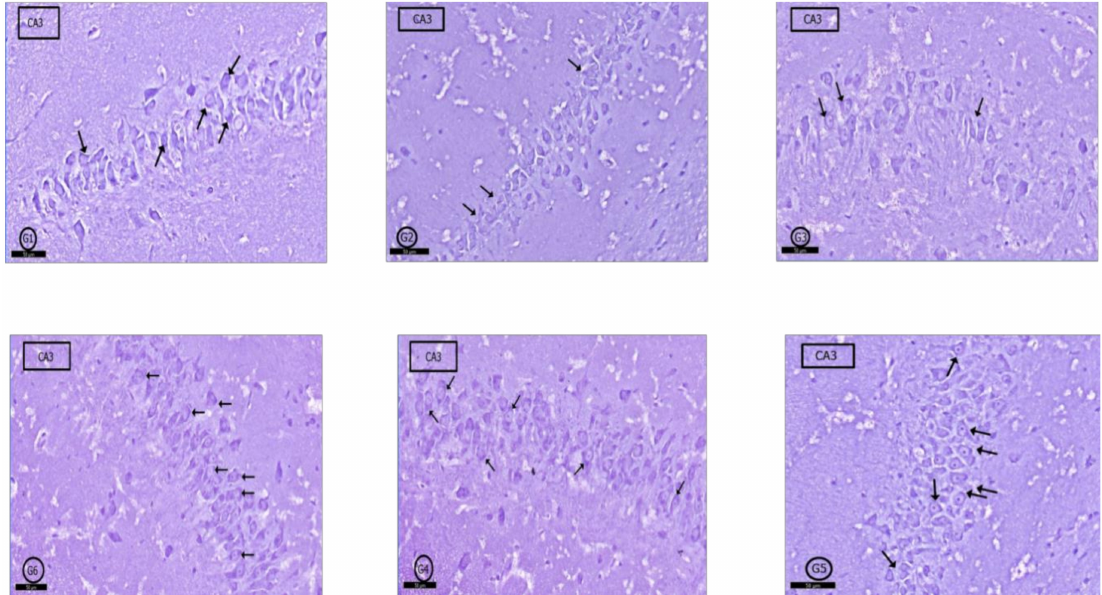
Figure 7. Photomicrographs of CA3 area of rat hippocampus proper: In control rats ( G1 ), pyramidal cells showed heavily studded cytoplasm with Nissl granules (arrows). In ( G2 ) (PILO rats) and ( G3 ) (PILO+LPS rats), marked decrease in Nissl granules content was observed in pyramidal cells (arrows). On the other hand, Nissl granules were increased (arrows) mildly in ( G4 ) (PILO+LPS+VPA rats), moderately in ( G5 ) (PILO+LPS+Celecoxib rats) and markedly in ( G6 ) (PILO+LPS+VPA+Celecoxib rats). Stain, toluidine blue. Bar 50 µ